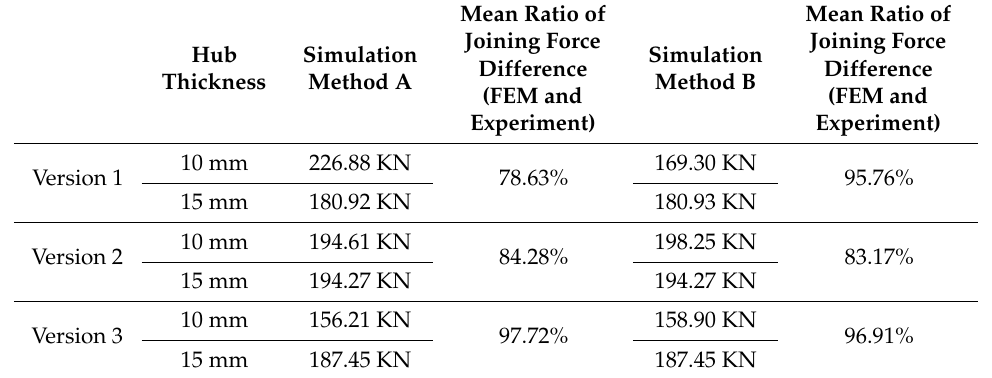
Table 5. Statistical table of bonding force data for different COFs in three versions of geometries. Mean Ratio of Joining Force Simulation Hub Difference Method B Thickness Method A (FEM and Experiment)